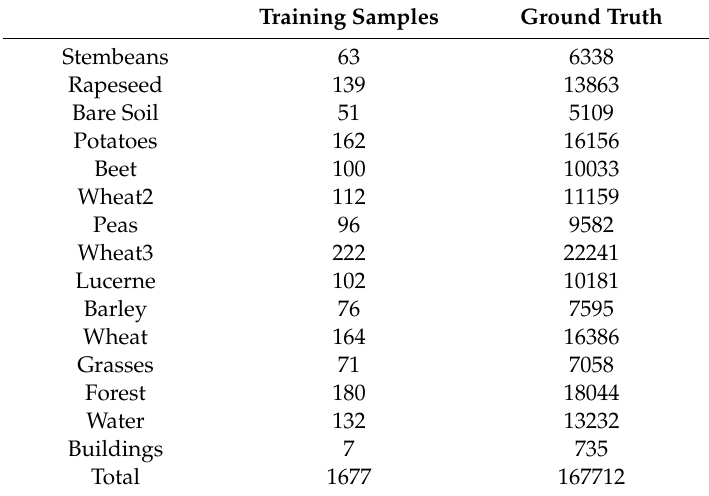
Table 1. Number of training samples and ground truth samples on Flevoland